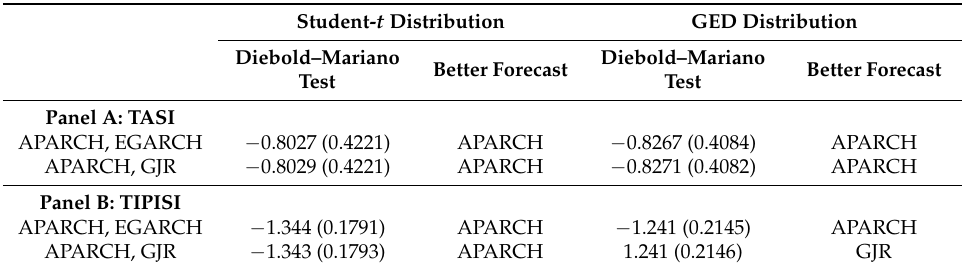
Table 9. Diebold–Mariano test for forecast comparison of the TASI and TIPISI after excluding periods of high volatility. The table presents Diebold–Mariano test from 1 July 2009 to 3 August 2014 using Student- t and GED distribution. Panel A displays the Diebold–Mariano test for the TASI using Student- t and GED distribution. Panel B displays the Diebold–Mariano test for TIPISI using Student- t and GED distribution. Numbers in parentheses are the p